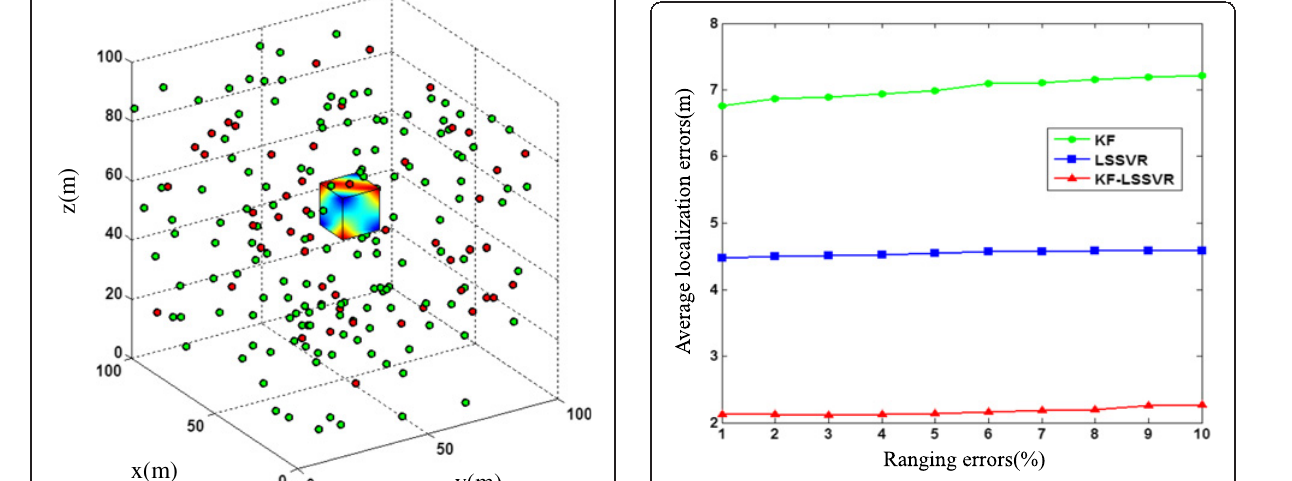
Fig. 2 Relationship between average localization errors and ranging